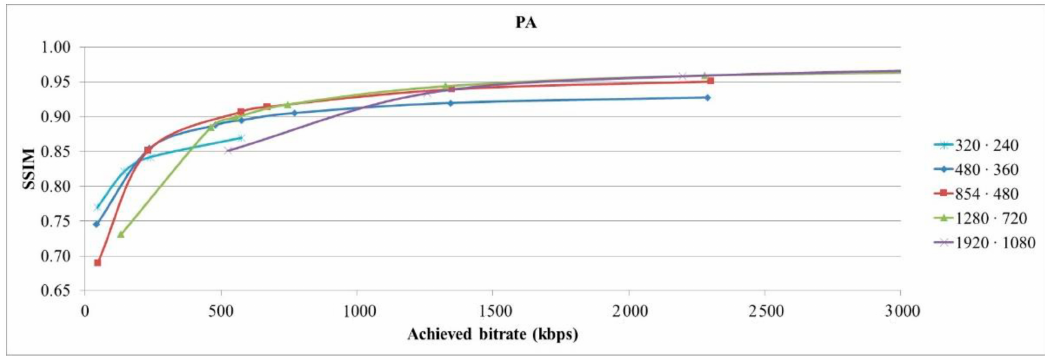
Figure 2. SSIM-achieved bitrate curves for Pedestrian Area video sequence.